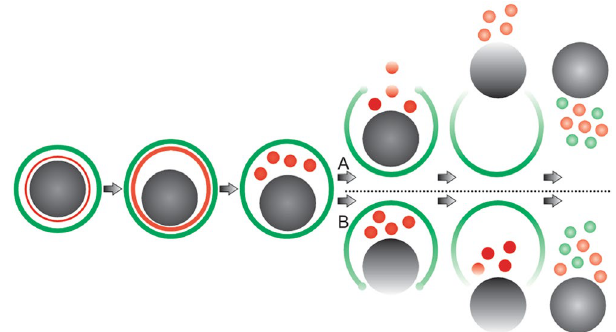
Figure 9. New model for egress. The gametocyte (gray) is surrounded by the PVM (red) and RBCM (green). The first sign of egress is swelling of the two membranes. Next, rupture and vesiculation of the PVM take place followed by the opening of a single stabilized pore in the RBCM. Two alternative positions of the pore were seen. The most common case was localization of the pore towards the PVM vesicles (A), which was seen in most females and all males. In more rare cases, and only detected in females, the pore was sited towards the parasite (B). Curling of the pore was suggested by the thickening of the rim detected in some events. The last step is the vesiculation of the RBCM resulting in a free female gamete or male residual